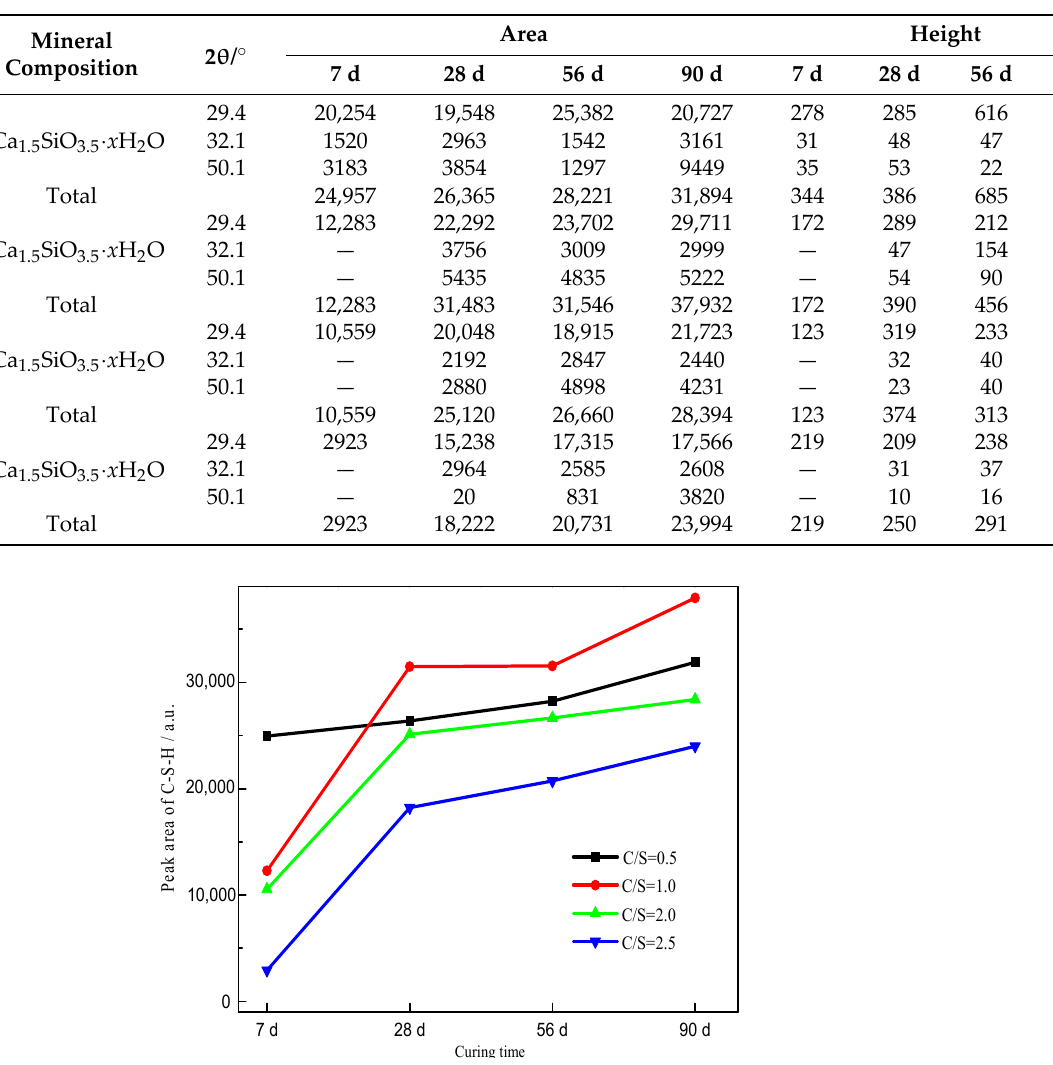
Table 3. XRD peaks of C-S-H.